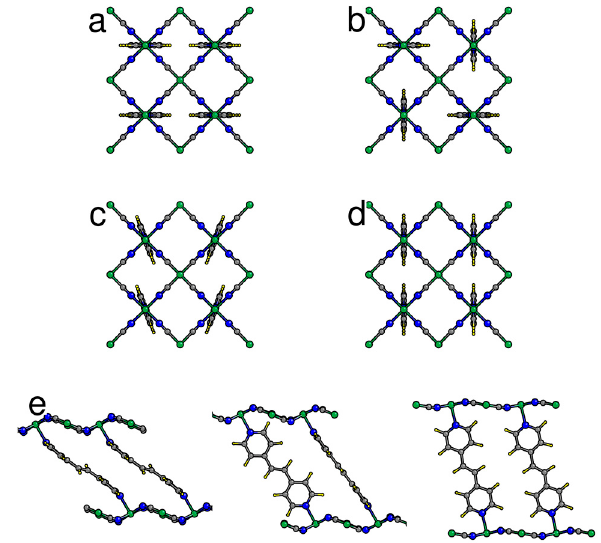
Figure 1. Examples of possible ordering patterns for Bpene pillars in NiBpene as projected onto the bc plane: ( a ) [b]-type: projected Bpene coordinates extend primarily along the b axis; ( b ) [bc]-type: an alternation of projected Bpene orientations along the b and c axes; ( c ) canted [c] type; ( d ) [c]-type; ( e ) schematic of NiBpene cell expansion upon CO 2 sorption, projected onto the ca plane (CO 2 not shown). Changes in Bpene orientation upon expansion are based on DFT calculations.